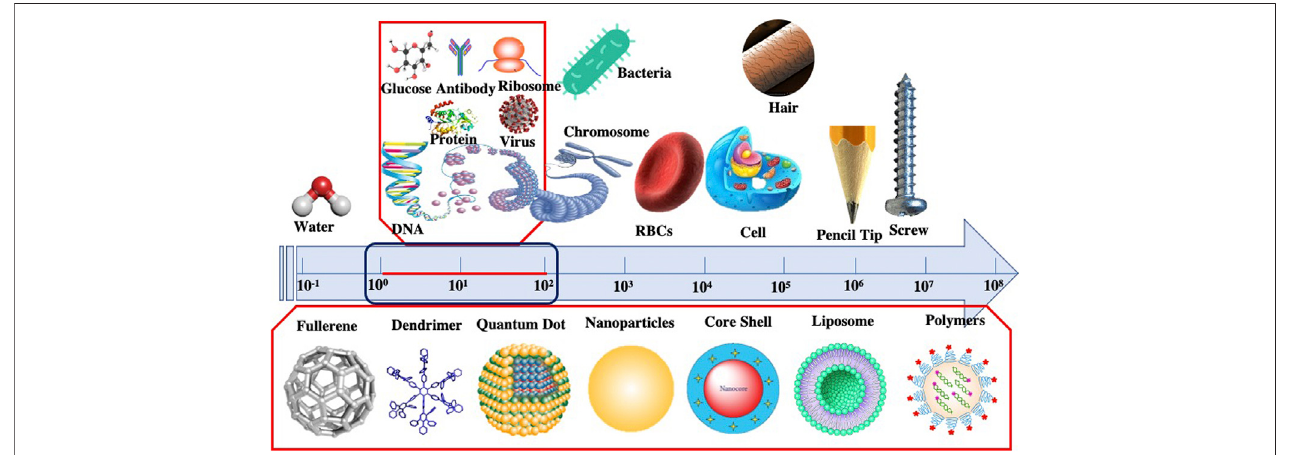
FIGURE 1 | Comparative Size scale from macroscale to nanoscale represented by different